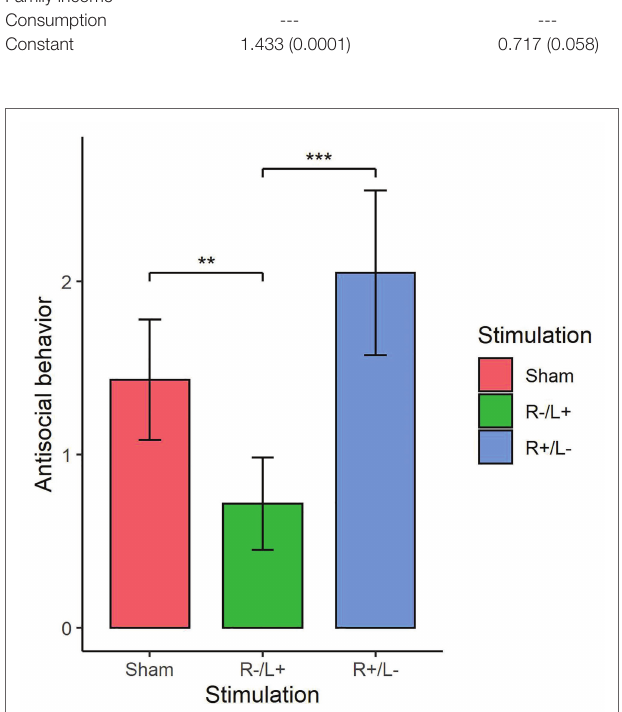
FIGURE 5 | Antisocial behavior at a cost of 1:3 tokens in three stimulation conditions. Error bars indicate 95% CI. Asterisks indicate significant differences in behavior between